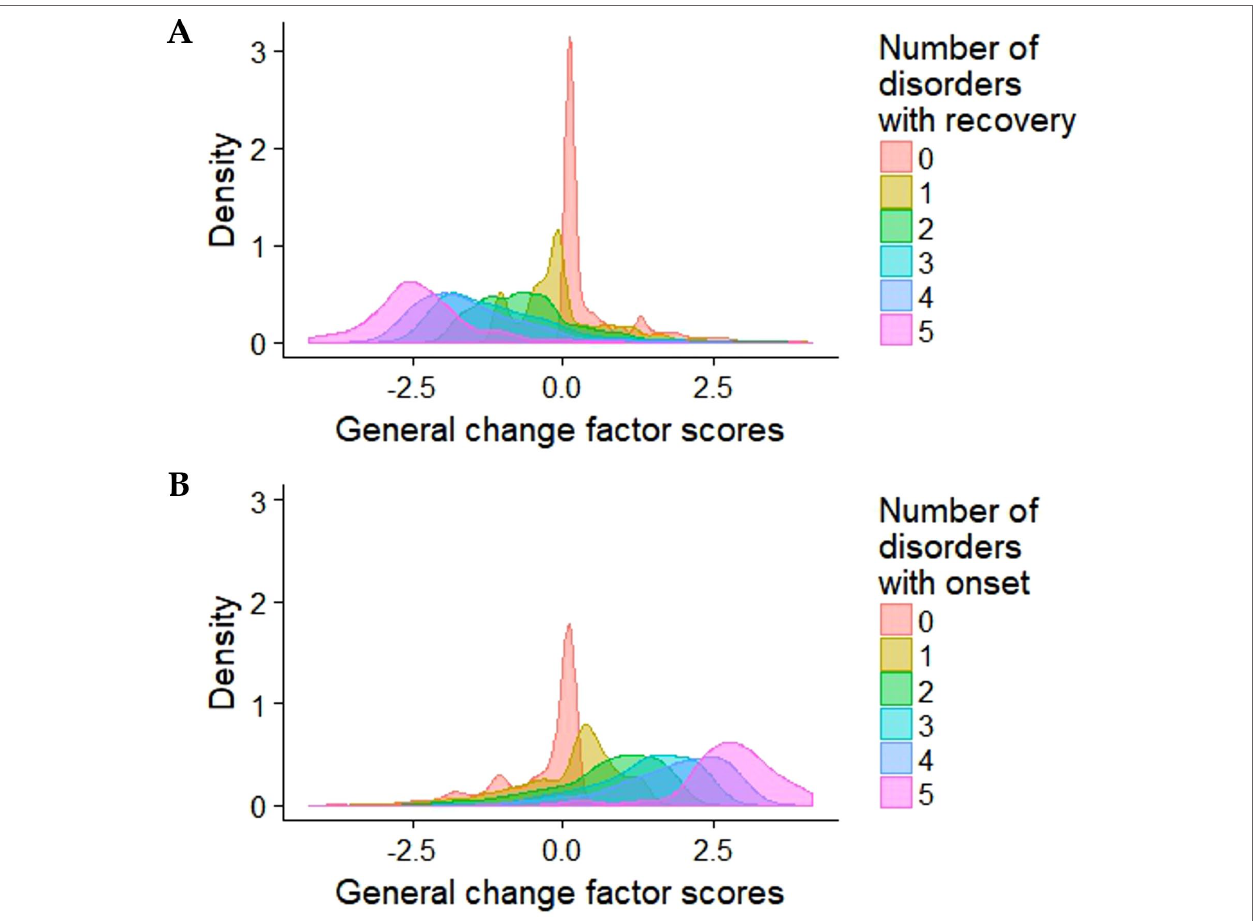
FIGURE 2 | The general factor scores by the frequency of disorder recovery (A) and onset (B)